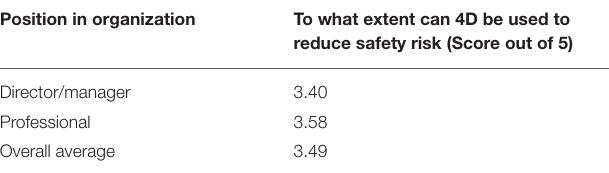
TABLE 8 | Perception of 4D as a tool to reduce safety